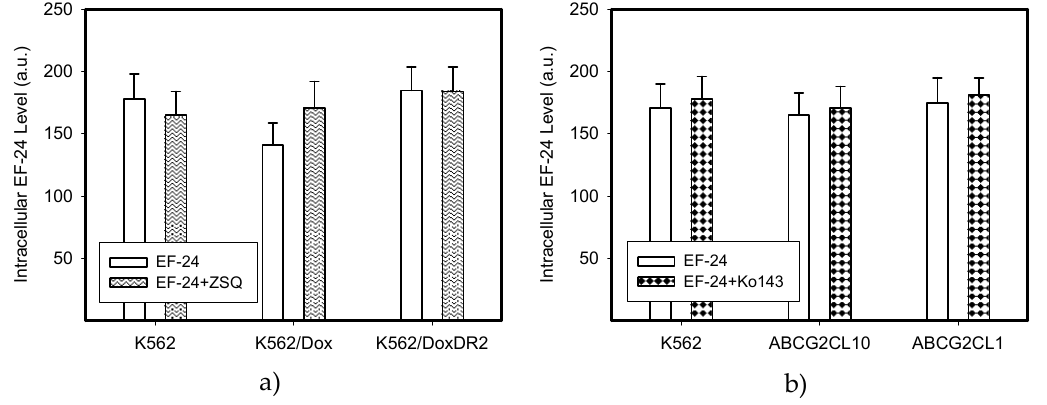
Figure 9. Intracellular levels of EF-24 in cells expressing ABCB1 or ABCG2. The parental cell line K562, which does not express any of the transporters was used as a control. ( a ) Relative intracellular levels of EF-24 in cells overexpressing ABCB1 transporter. Cells were treated with EF-24 or with EF-24 + inhibitor zosuquidar trihydrochloride (ZSQ), as indicated. The experimental points represent mean values from three replicate experiments, with standard deviations. ( b ) Relative intracellular levels of EF-24 in cells overexpressing ABCG2 transporter. Cells were treated with EF-24 or with EF-24 + inhibitor Ko143, as indicated. The experimental points represent mean values from three replicate experiments, with standard deviations. Table 2. Effect of ABCB1 or ABCG2 expression on cell proliferation and viability in EF-24 treated K562 cells. ZSQ, zosuquidar trihydrochloride.